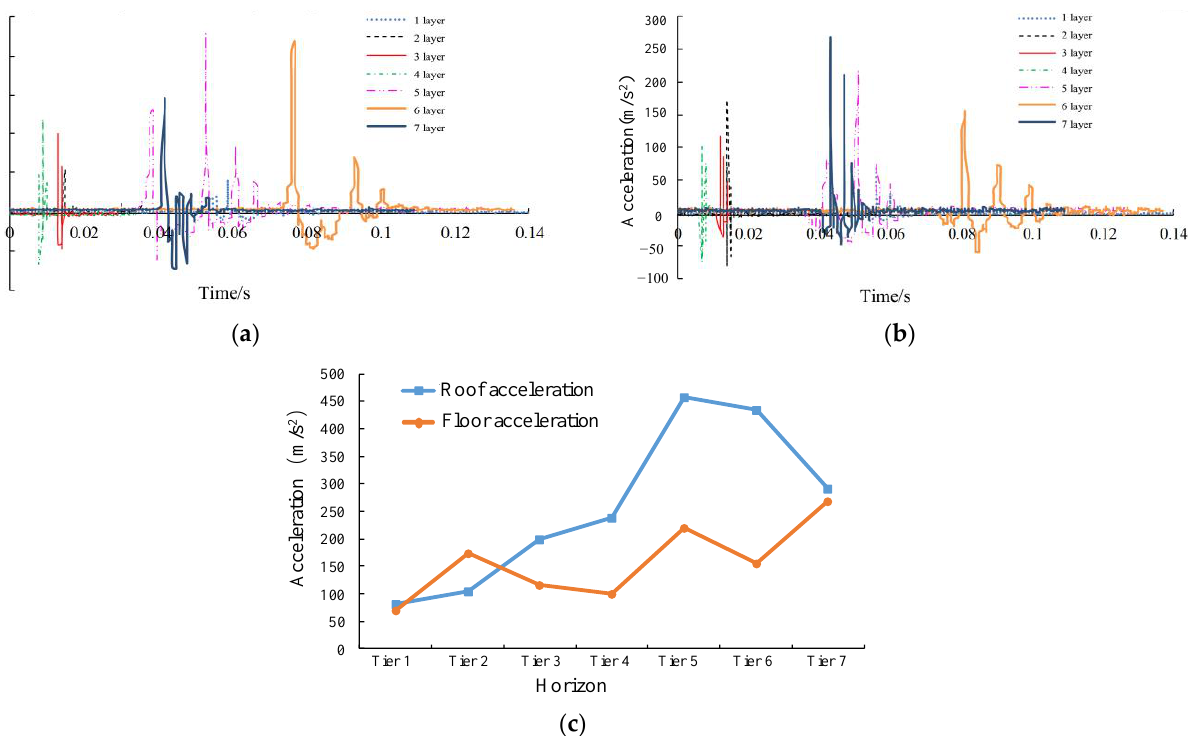
Figure 16. Acceleration response characteristics of each layer when the pendulum height is 0.2 m. ( a ) Acceleration at the roof of surrounding rock; ( b ) Acceleration at the floor of the roadway; ( c ) Peak acceleration at each level.